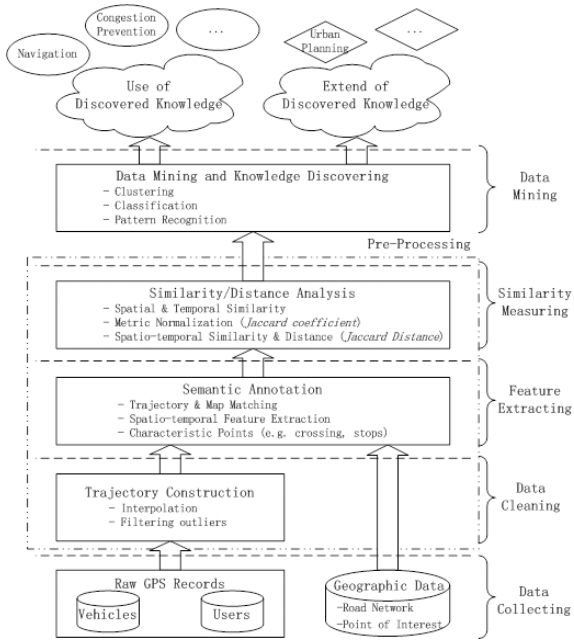
Fig. 5. Trajectory pre-processing